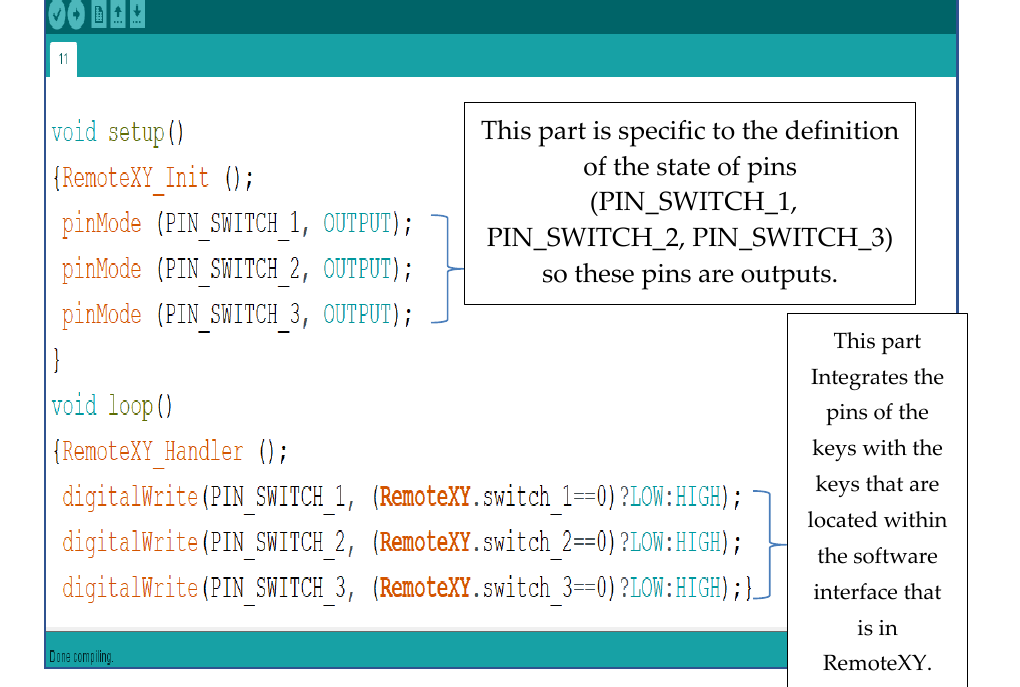
Figure A1. The first part of the executed code used to control lighting and sockets.